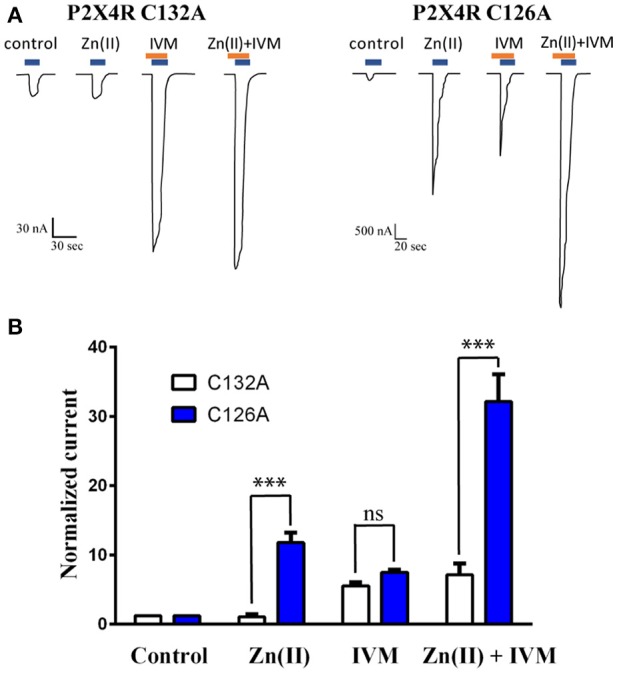
Loss of Zn(II) modulator activity in the C132A P2X4R mutant but not the C126A mutant. (A) Representative recordings of 1 μM ATP-gated currents in two P2X4R mutants (C132A and C126A) in the absence or presence of 10 μM Zn(II), 3 μM IVM and joint application of Zn(II) plus IVM. ATP and IVM applications are represented by blue and brown rectangles, respectively. Each set of recordings is derived from a single oocyte expressing either the C132A or the C126A mutants. (B) Statistical analyses of a set of 5 separate oocytes expressing the C132A mutant (open bars) and 4 oocytes expressing the C126A mutant (closed bars) (***p < 0.001); ns (not statistically significant).